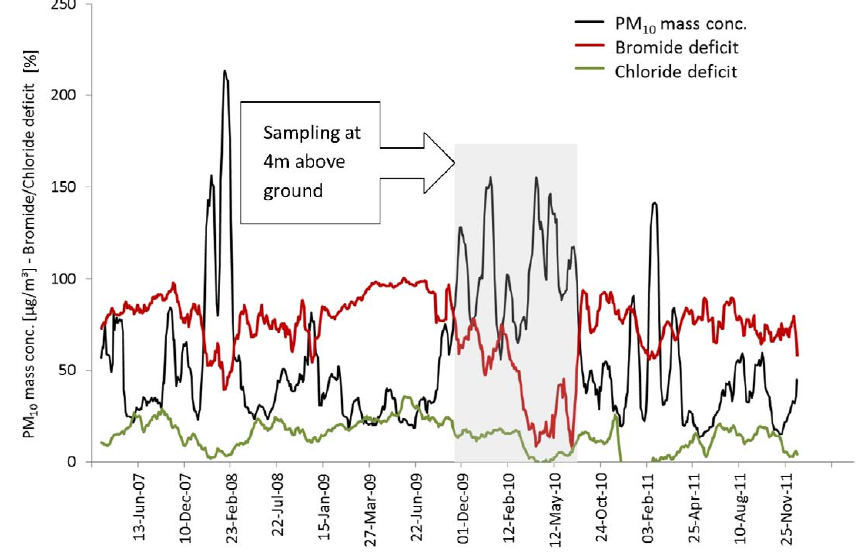
Figure 9. Variability of bromide and chloride deficit in comparison to the total PM 10 mass concentration (all curves represent 10 sample running mean) and the